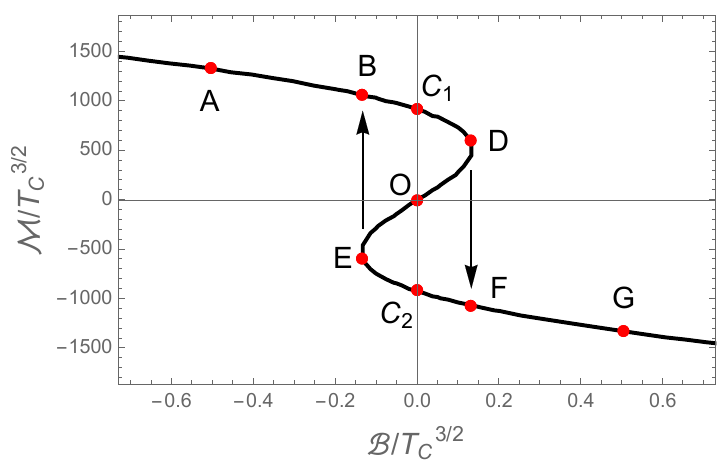
Figure 2 . External magnetic (cid:12)eld dependence of the